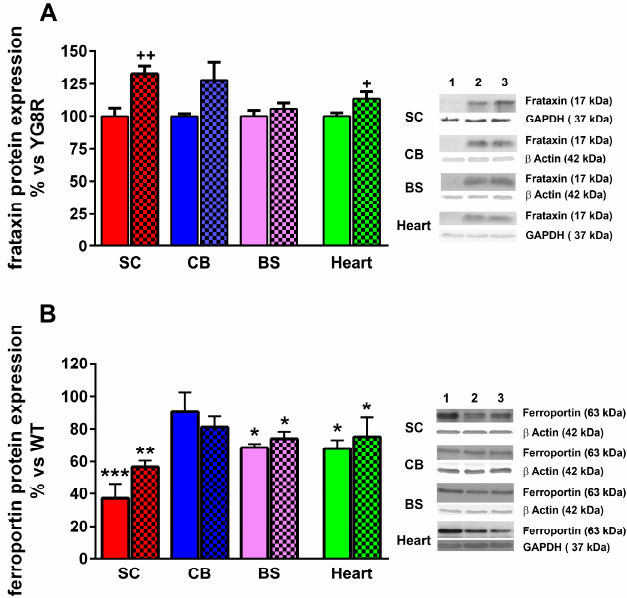
Figure 5. LGF treatment increases frataxin expression in YG8R mice spinal cord. ( A ) represents the effect of LGF on frataxin expression, analyzed by Western blot in the spinal cord (SC, red bars), cerebellum (CB, blue bars), brain stem (BS, lilac bars), and heart ( green bars) of WT, YG8R ( uniform bars), and YG8R+LGF (bars with mes h) mice. Note that LGF enhances frataxin expression in the spinal cord and heart; In ( B ) the effect of LGF on ferroportin expression is observed in the same structures. Note that the level of this compound is significantly reduced in most structures in YG8R mice versus WT mice. Lane 1 (WT), Lane 2 (YG8R), Lane 3 (YG8R+LGF). Results are the mean ± SEM of three (in the case of spinal cords) or 6–8 (in the rest of structures) independent animals. * p < 0.05, ** p < 0.01, *** p < 0.001 vs. WT; + p < 0.05, ++ p < 0.01 vs. YG8R.